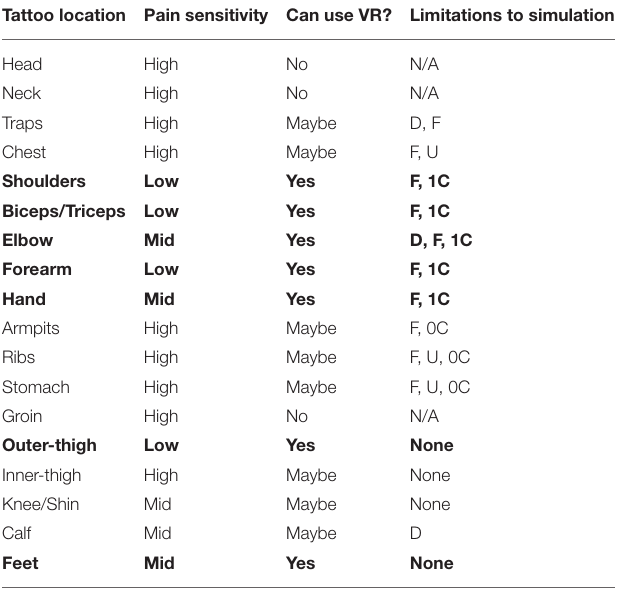
TABLE 1 | Design considerations for designing VR content for use during a tattoo procedure. Tattoo location Pain sensitivity Can use VR? Limitations to